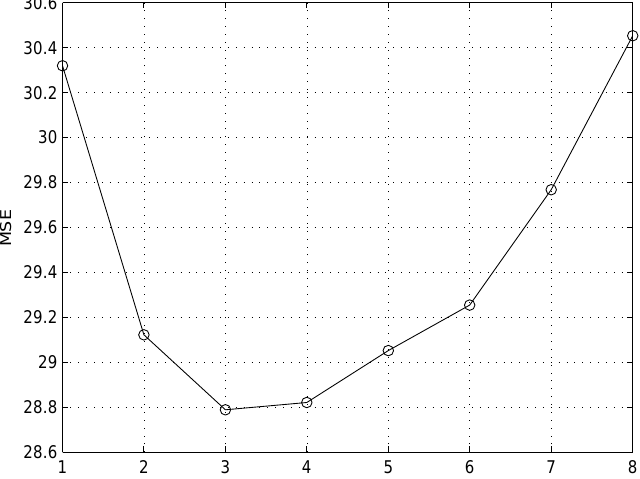
Figure 3. Performance of the proposed method in terms of MSE as a value of a under the condition of b = 1 and m = 3